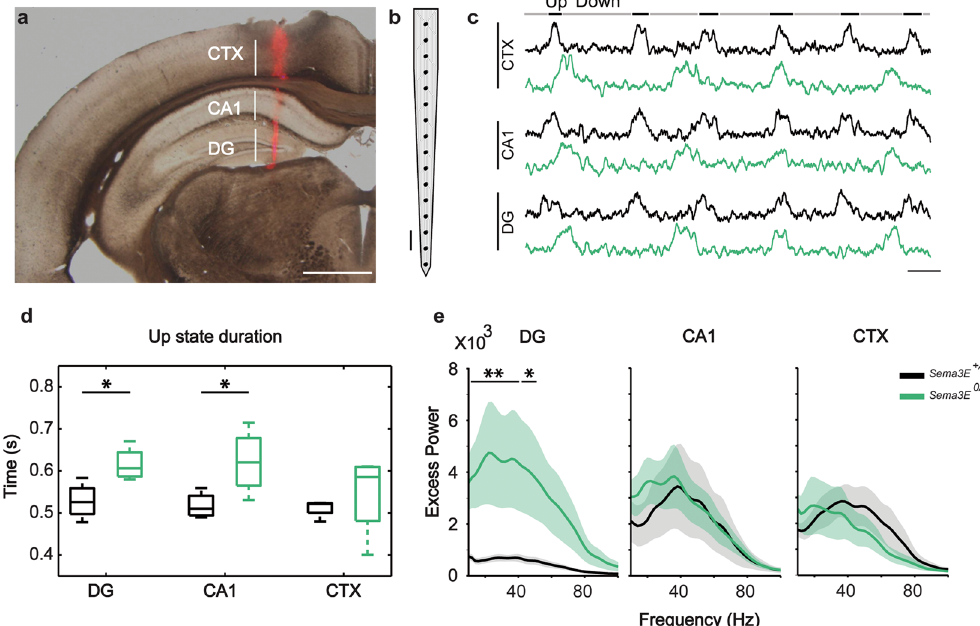
Figure 7. Alterations in the spontaneous oscillatory activity in Sema3E 0/0 mice. ( a) Representative half coronal section (2.0 mm posterior to Bregma, 1.0 mm lateral from midline) showing the track of a 1 × 16 multichannel recording probe covering the cerebral cortex (CTX) and hippocampus (CA1 and DG) of a mouse. Track reconstruction was accomplished following the tissue deposition of the DiI that was applied to probe prior to insertion. ( b ) Schematic representation of the 16-multichannel recording probe used to record neuronal activity. ( c ) Representative examples showing multi-unit activity traces (200–1500 Hz) simultaneously recorded in the cerebral cortex (CTX) and hippocampus (CA1 and DG) of a Sema3E + / + (black) and a Sema3E 0/0 (green) mouse during slow oscillatory activity. No vertical scale because they are arbitrary units (see materials and Methods). ( d ) Up state durations recorded in the hippocampus (DG and CA1) and cerebral cortex (CTX) of Sema3E + / + (black, n = 4) and Sema3E 0/0 (green, n = 4) mice. Box plots represent the first and third quartiles with the median depicted by the horizontal line within the box and extreme values shown by whiskers. ( e ) Average excess power (ratio between the mean power spectral density and the fit of the 1/f decay) during local field potential Up states recorded in the hippocampus (DG and CA1) and cerebral cortex (CTX) of Sema3E + / + (black, n = 4) and Sema3E 0/0 (green, n = 4) mice. Data expressed as mean ± S.E.M (shadow). * P < 0.1, ** P < 0.05, Wilcoxon rank-sum test. Scale bar: a = 1 mm; b = 100 μ m; c = 0.5